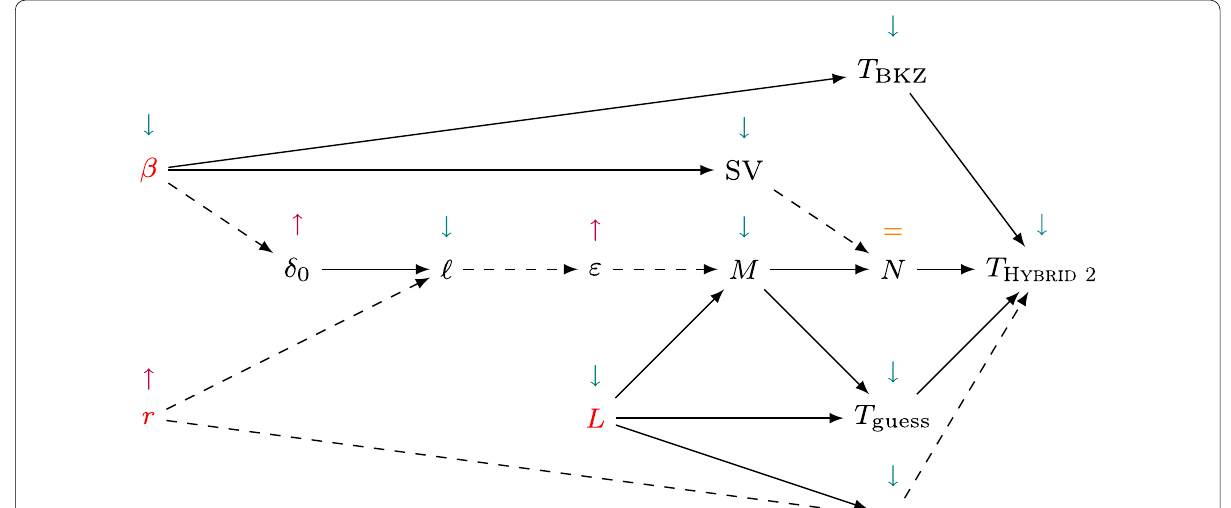
Fig. 4 Parameter relations in H ybrid 2 and value changes from H ybrid 1 to H ybrid 2 . The attack can choose the value for parameters in red color (i.e., β , r and L ), which then determine the value for other